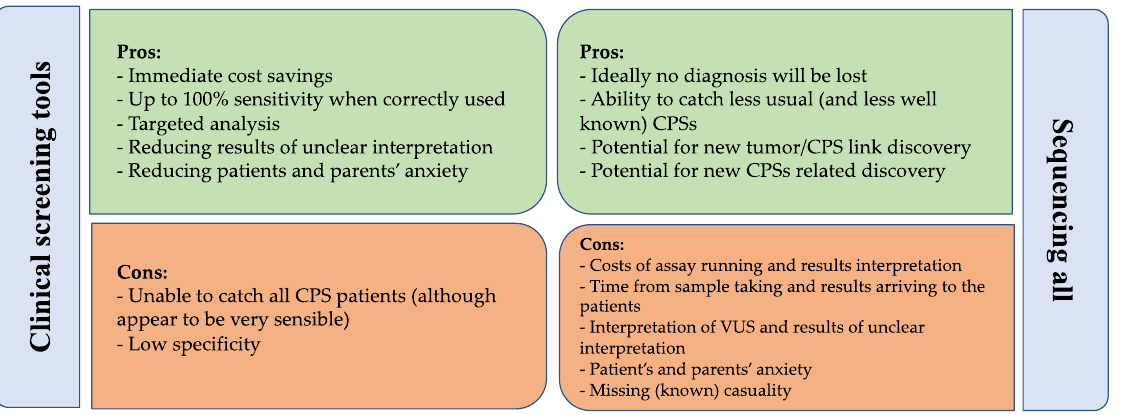
Figure 1. Discussion of pros and cons of screening for cancer predisposition syndrome in children with cancer with a clinical screening tool or with universal sequencing. Abbreviations: CPR—cancer predisposition syndrome. VUS—variant of unknown significance.